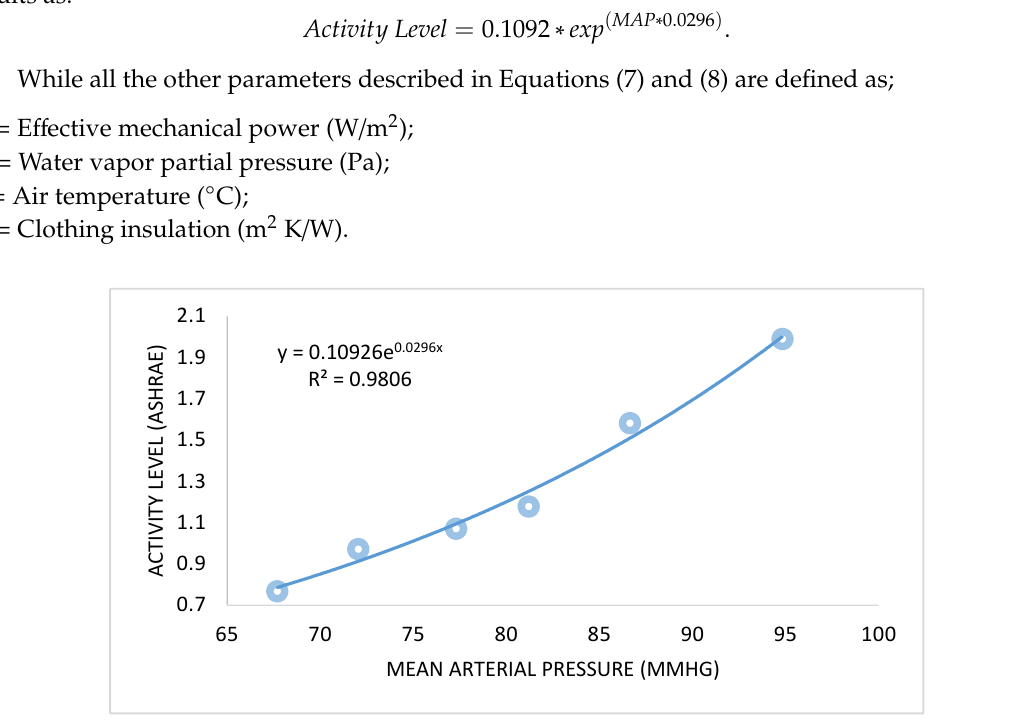
Figure 3. Mean arterial pressure ( 𝑀𝐴𝑃 ) and metabolic activity.